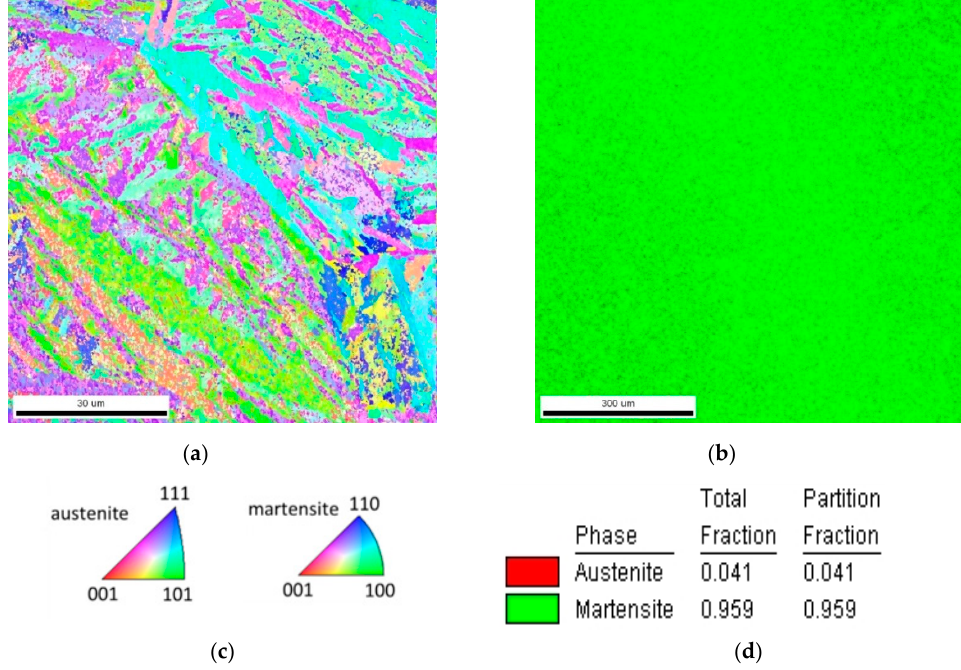
Figure 4. ( a ) EBSD map of the hardened and tempered steel.; ( b ) Phase map indicating ≈ 95% martensite in the microstructure. (c) Inverse pole figure for map in (a); (d) legend for phase fraction in (b).